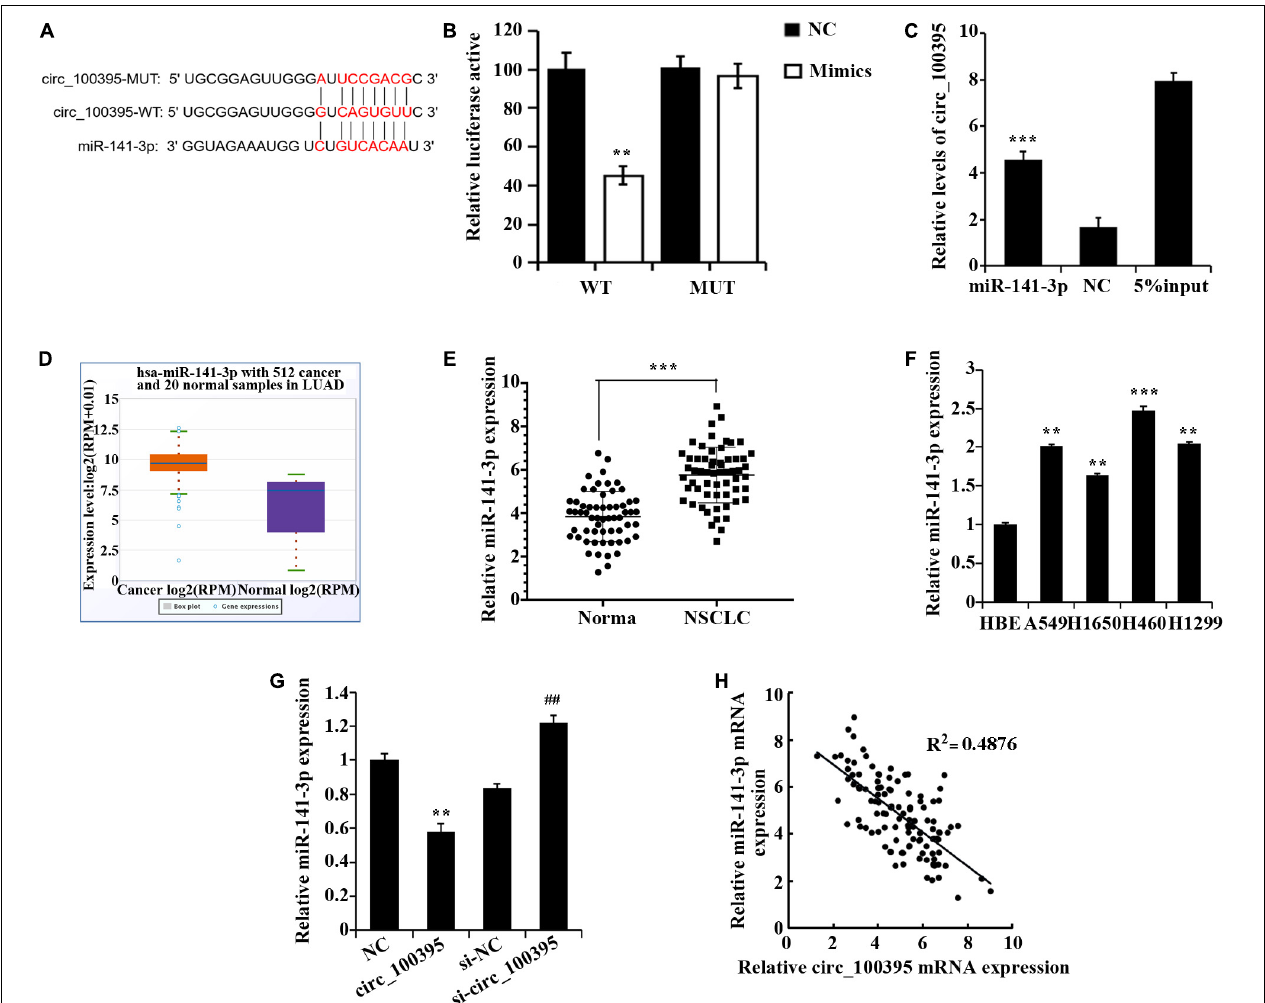
FIGURE 3 | circ_100395 can as a sponge to adsorb miR-141-3p. (A) The predicted targeting sequence of circ_100395 and miR-141-3p. (B) Dual-luciferase reporter assay-based validation that circ_100395 targets miR-141-3p. ** p < 0.01 vs NC group. (C) RNA pull down assay-based validation that circ_100395 targets miR-141-3p. *** p < 0.001 vs NC group. (D) MiR-141-3p expression in non-small cell lung cancer (NSCLC) tissues in StarBase3.0 database; (E) qRT-PCR detection of miR-141-3p expression in NSCLC tissues and paracancerous tissues. *** p < 0.001 vs Normal group. (F) qRT-PCR detection of miR-141-3p expression in NSCLC cell lines and human bronchial epithelial cell line 16 HBE-T. ** p < 0.01 and *** p < 0.001 vs HBE. (G) qRT-PCR detection of miR-141-3p expression in H1650 cells after overexpression and interference of circ_100395. ** p < 0.01 vs NC group, ## p < 0.01 vs si-NC group. (H) A negative correlation between circ_100395 and miR-141-3p expression in NSCLC